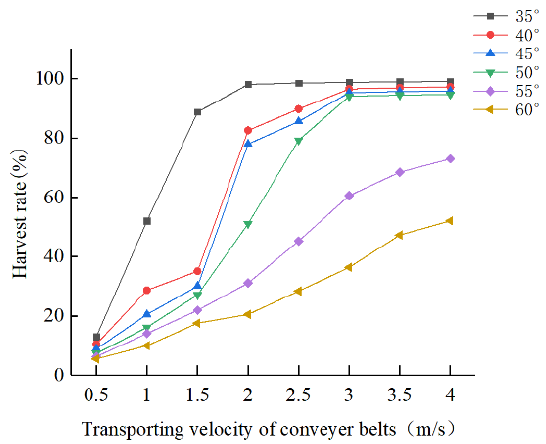
Figure 13. Variation curve of sweet potato vine harvest rate with conveying velocity under different conveying inclination angles. conveying inclination angles.